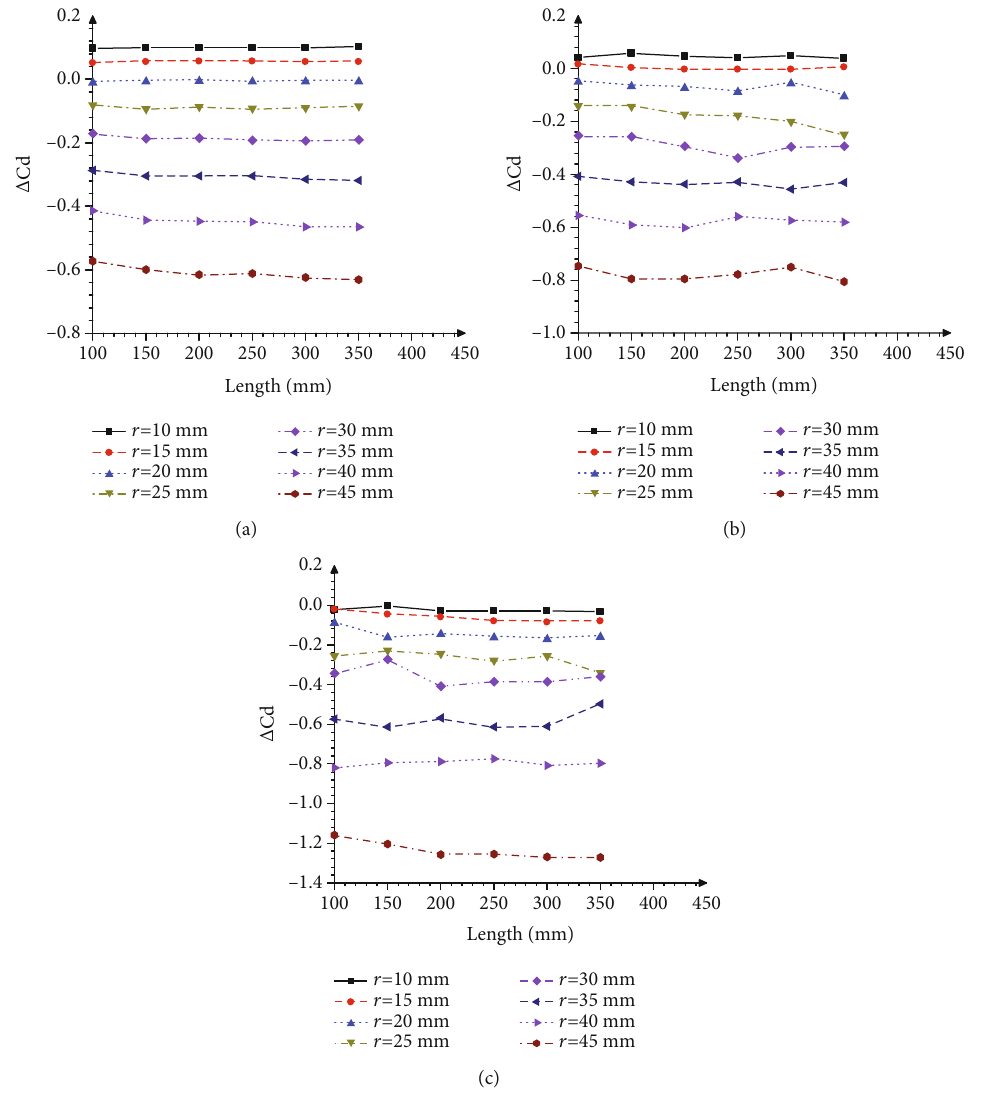
Figure 10: Drag reduction rate and length of the aerospike. (a) Ma 1.5, (b) Ma 2, and (c) Ma curve of the head of the aircraft changes. The pressure curve of the head changes from the maximum downward decrease at the front end to a trend of fi rst increase and then decrease.